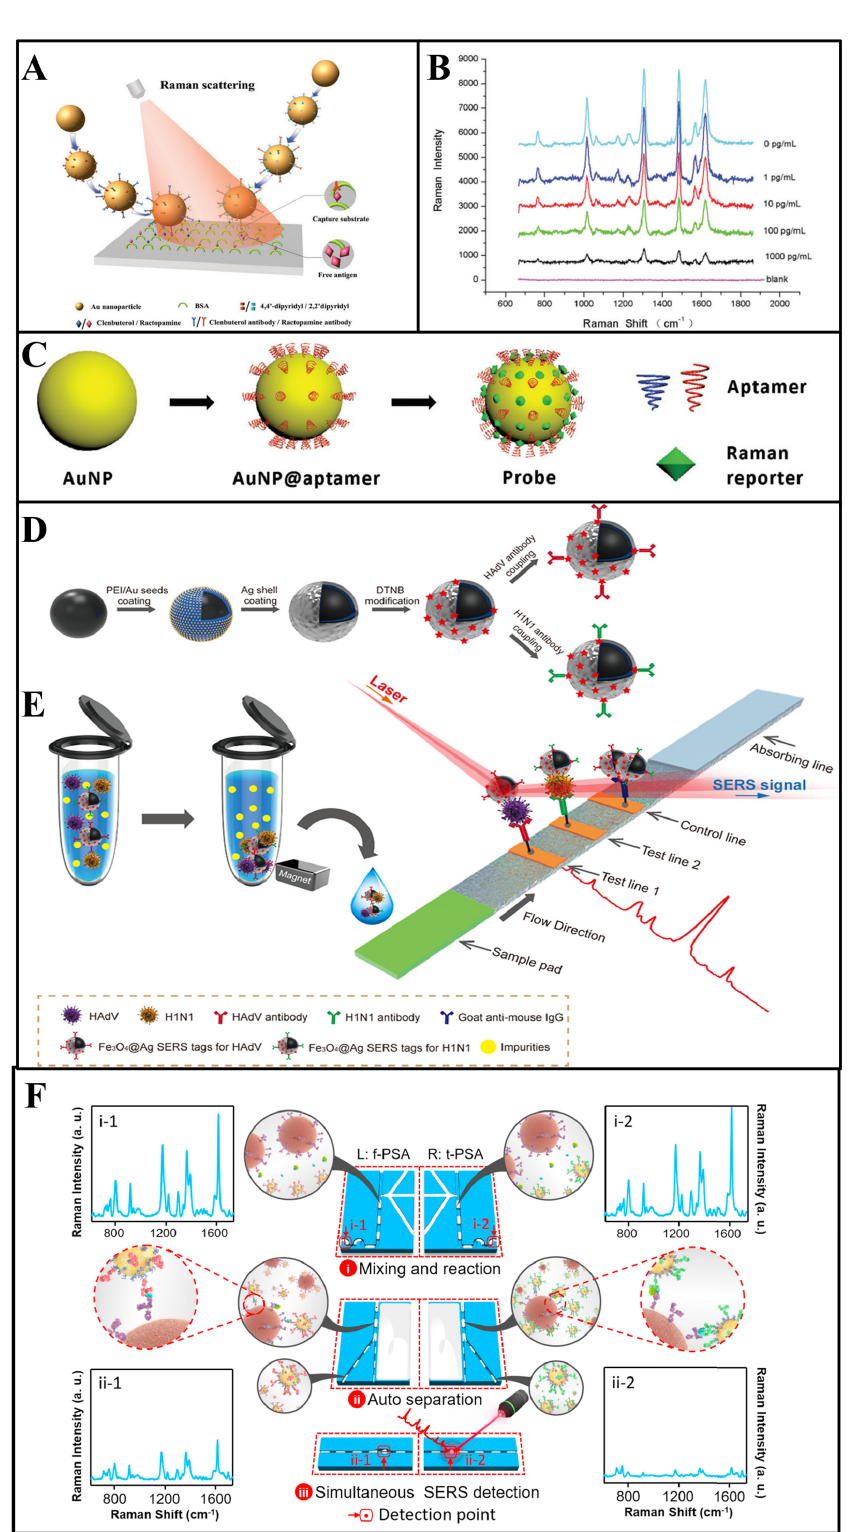
Figure 3. ( A , B ) Multiantibodies modified with gold nanoparticles for SERS multicomponent detection, and SERS spectra acquired with different clenbuterol and ractopamine concentrations [53]. ( C ) The fabricate of the aptamer-modified probe [56]. ( D , E ) Schematic diagram of the SERS strip for detecting viruses [57]. ( F ) Schematic design of the parallel microdroplet channels for simultaneous detection of f − PSA and t − PSA